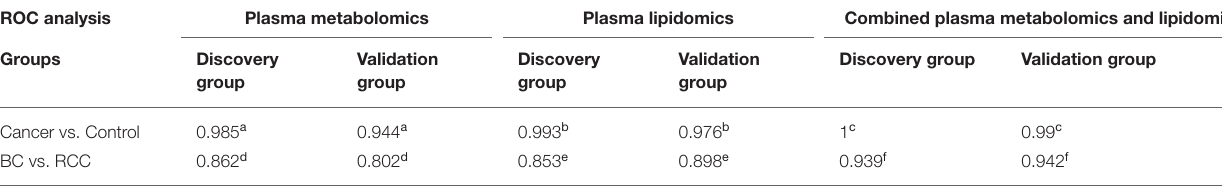
TABLE 4 | Performance of metabolomics/lipidomics panels for groups